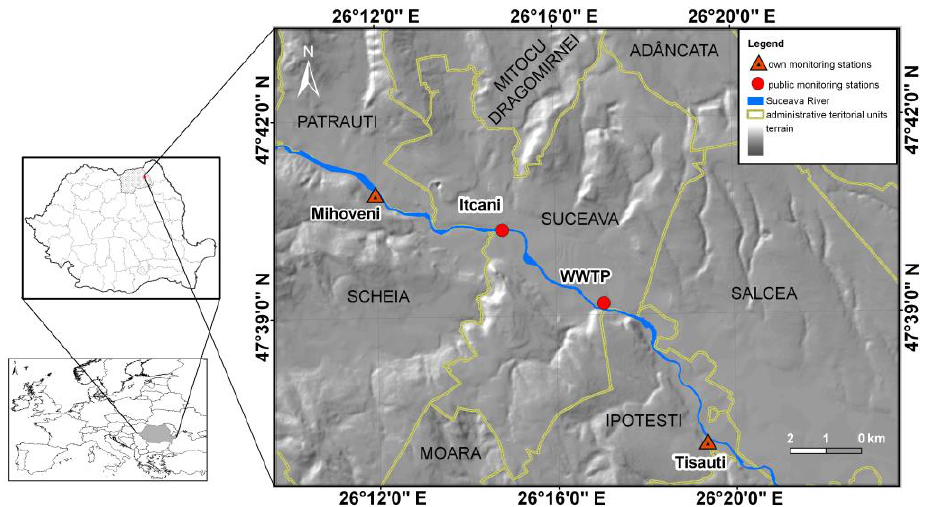
Figure 1. Geographical position of the study area and the location of stations included in this study.